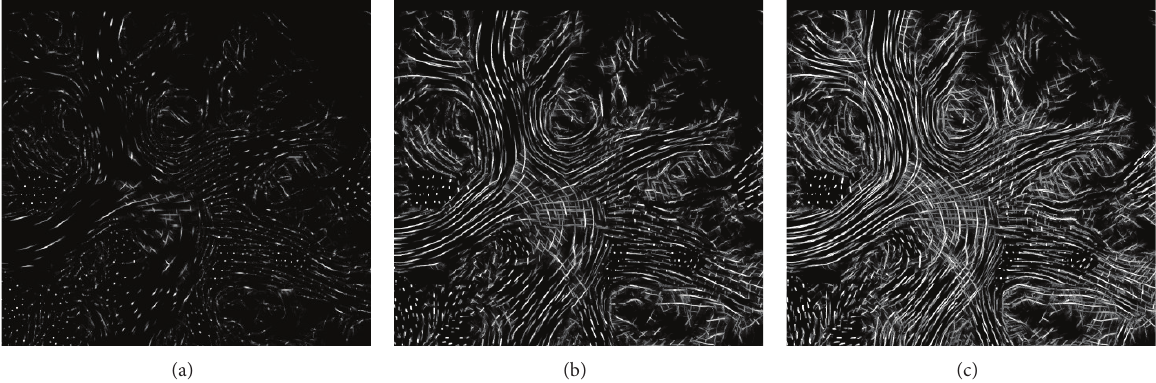
Figure 8: Combination of adjacent slices (zoomed details of transaxial slice image): single slice (a), 10 slices (b), and 20 slices (c) of the superresolution LIC dataset.